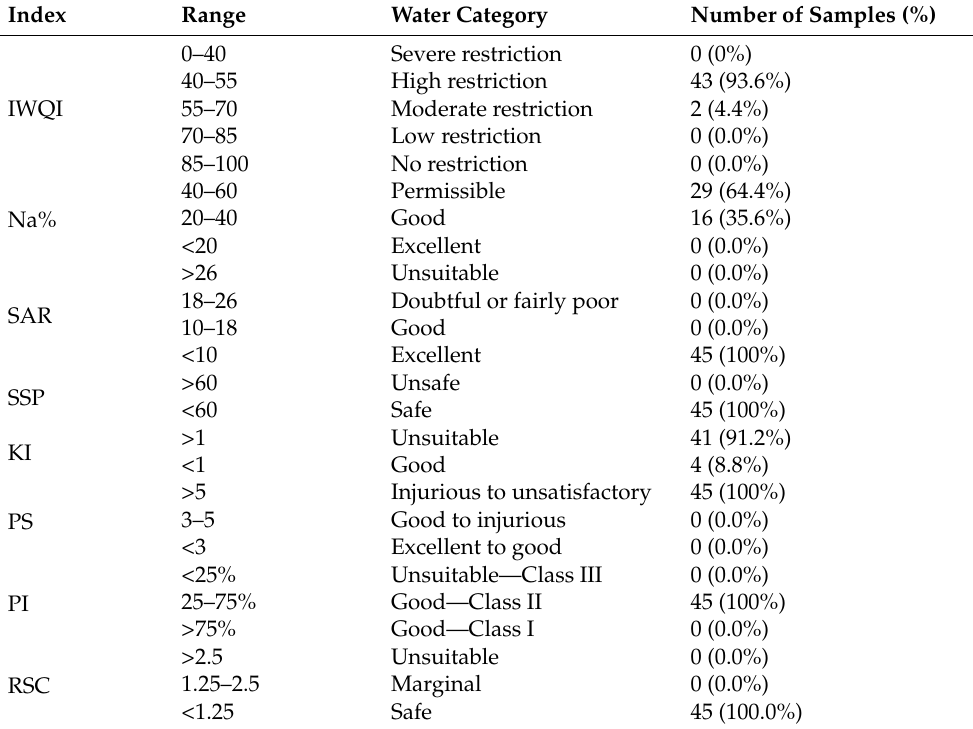
Table 5. Classification of the different IWQIs for irrigation according to the documented